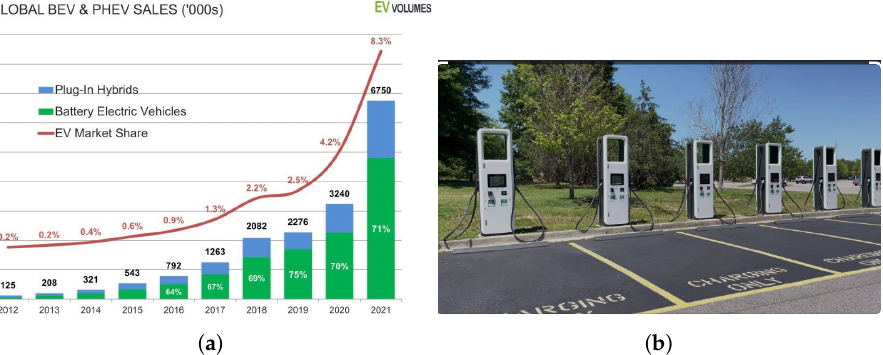
Figure 1. EV sales statistics and EV charging station example. Global EV sales increased 108% from a 4.2% market share in 2020 to a 8.3% market share in 2021 [2]. ( a ) Global EV sales; ( b ) electric vehicle charging hubs open in